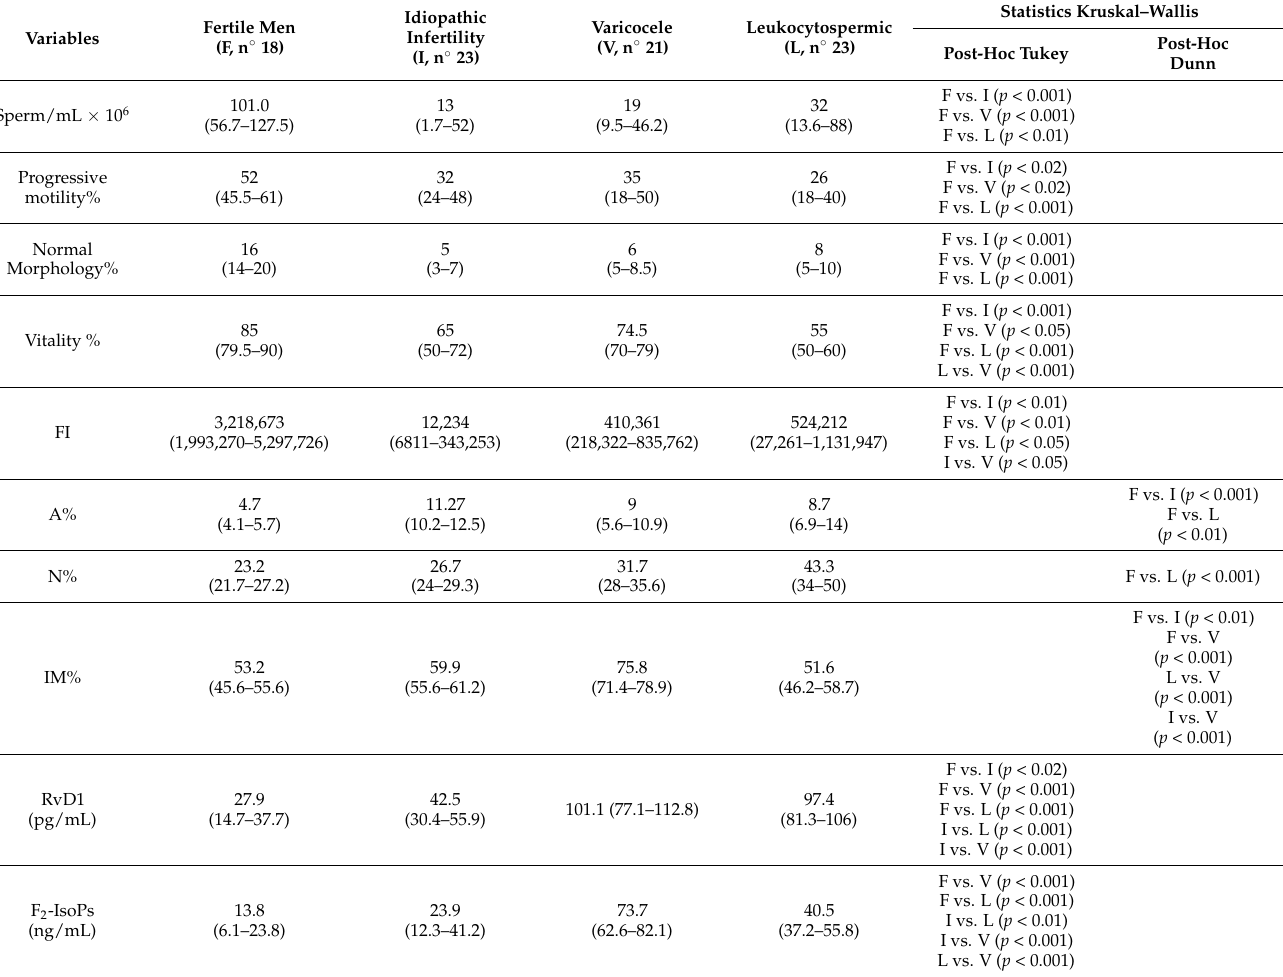
Table 3. Medians and Interquartile ranges (IQR) of all variables in the four groups (fertile men F, idiopathic infertility I, varicocele V, and leukocytospermic L). Statistics are also